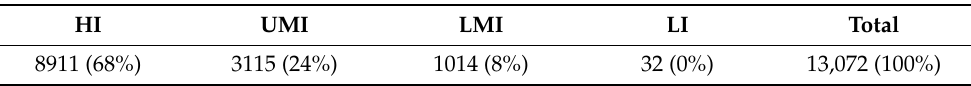
Table 2. Total number of radiotherapy linacs that were available worldwide in 2015 and reported in Lancet stratified by high, upper-middle, and low-income countries. HI UMI LMI LI Total 8911 (68%) 3115 (24%) 1014 (8%)